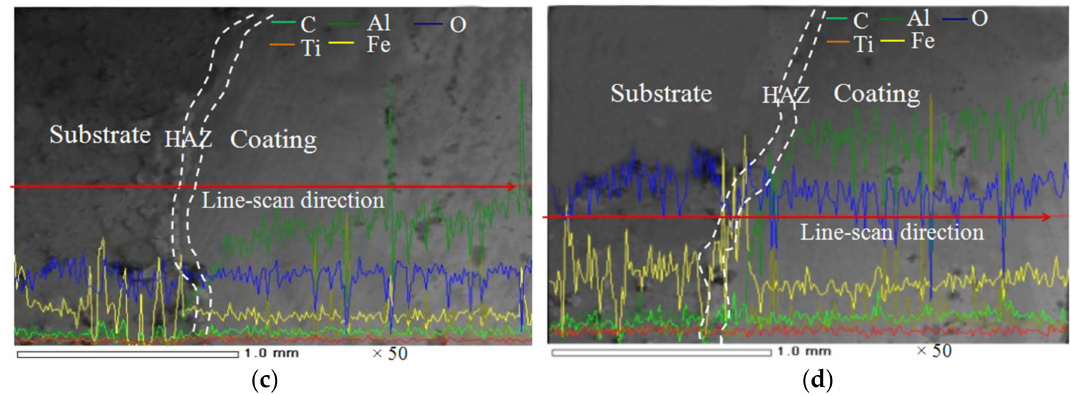
Figure 4. SEM image and EDS line-scan of coating cross-section, ( a ) Coating I; ( b ) Coating II; ( c ) Coating III; ( d ) Coating IV.